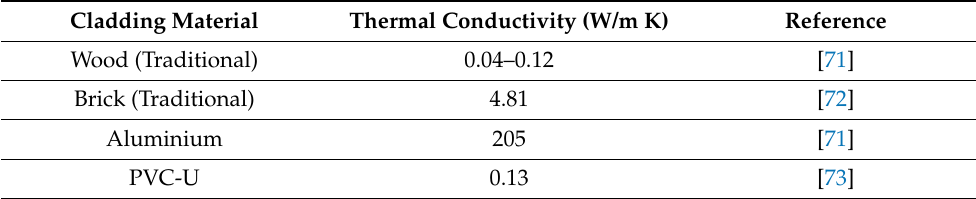
Table 4. Thermal conductivity of common cladding materials. Cladding